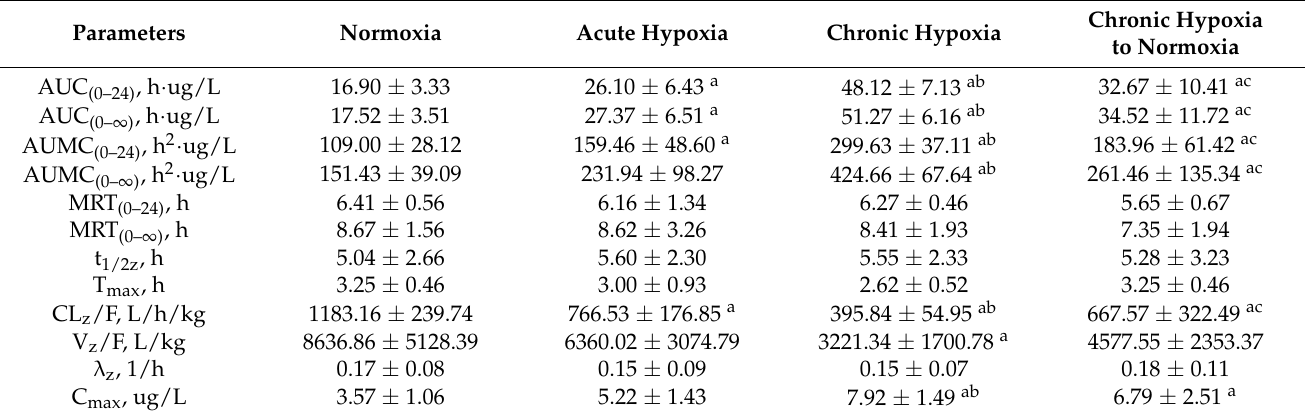
Table 8. Pharmacokinetic parameters of hydroxybosentan in rat plasma after exposure to high- altitude